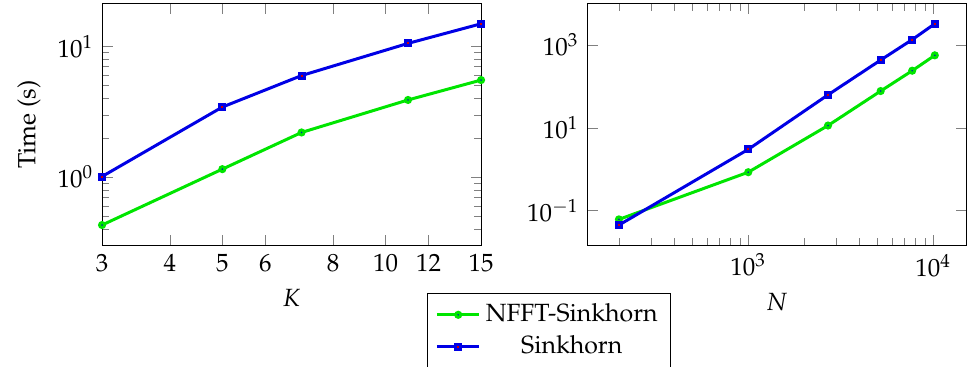
Figure 3. Computation time in seconds of MOT η with a circle-structured cost function with regular- ization parameter η = 0.1. Left : fixed N = 700. Right : fixed K = 3.